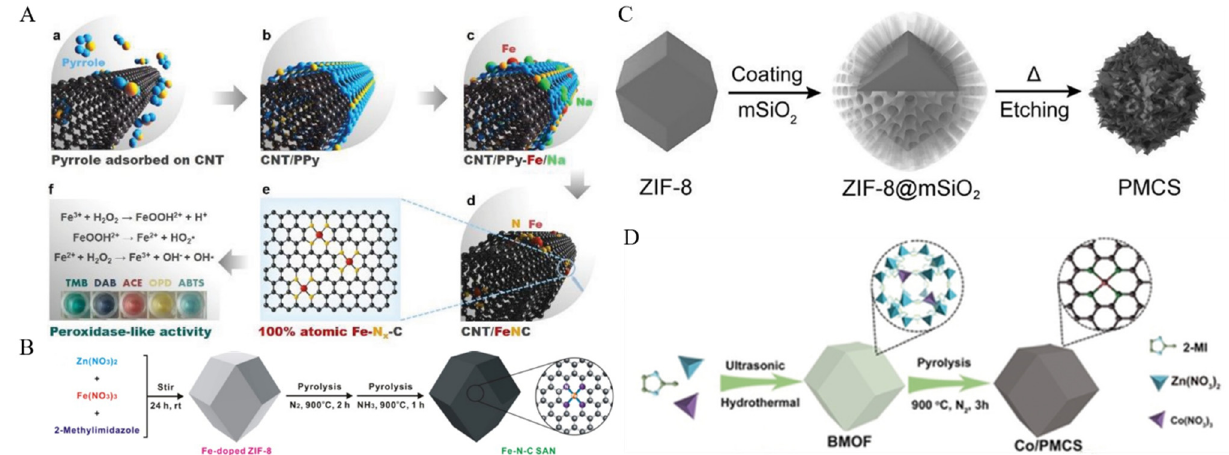
Figure 1. Preparation of SAzymes by pyrolysis. ( A ) CNT/FeNC. (a) Pyrrole adsorbed on CNT. (b) Polypyrrole coated on CNT to form CNT/PPy. (c) Metal cations adsorbed on CNT/PPy. (d) Pyrolysis to form CNT/FeNC. (e) Structure of Fe-Nx-C. (f) POD-like activity of CNT/FeNC. [40]. Copyright